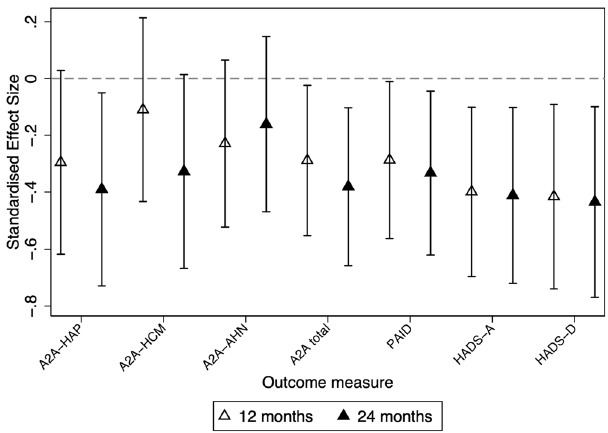
Fig. 3 Standardised effect sizes of secondary endpoints A2A, PAID and HADS. Values below zero indicate better outcomes in HARPdoc. The data are presented as estimated mean differences and 95% con fi dence intervals, with open triangles representing means of 12 month data; closed triangles representing means of 24-month data and bars representing 95% con fi dence intervals. Analysis is by a three-level random intercept linear regression regression model. A signi fi cance level of 5% (two sided) has been used. The standardised effect sizes for other secondary endpoints were not signi fi cant and are shown, together with numerical data for the depicted parameters, and the numbers providing data at each time point in each intervention, in Tables 4 and 6. Source data are available on request